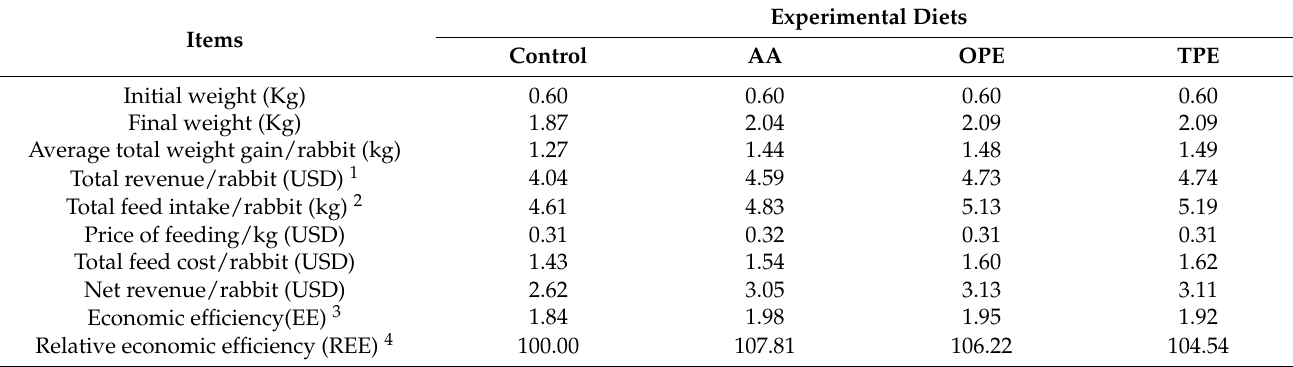
Table 7. Effect of dietary treatments on economic efficiency of rabbits